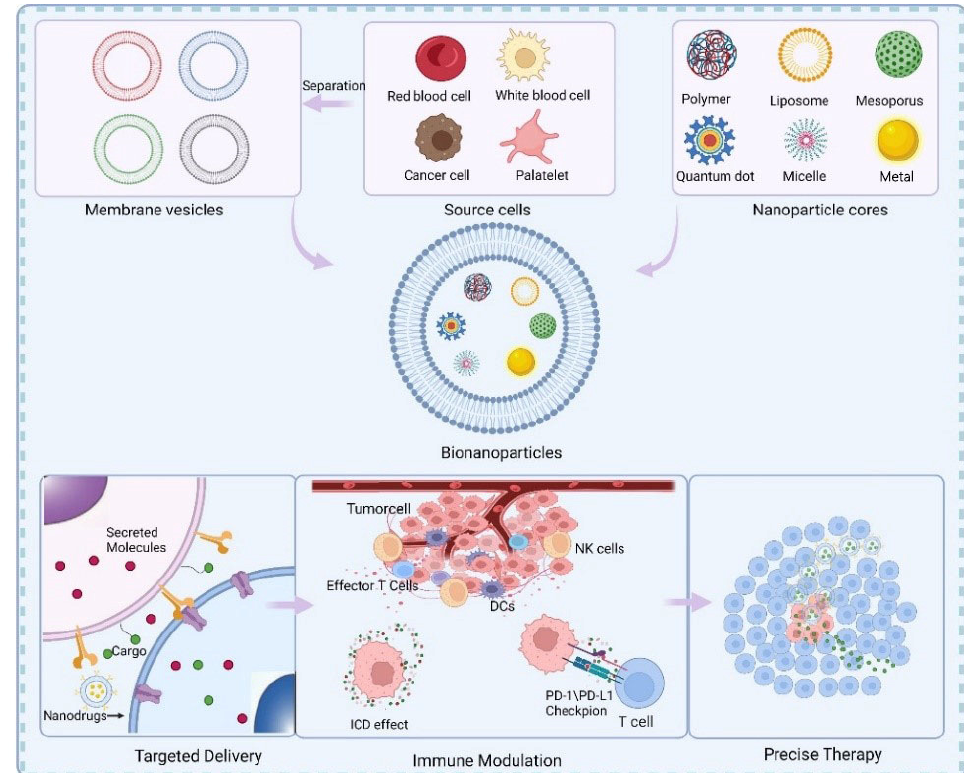
Figure 1. A schematic diagram of the preparation of membrane-coated biomimetic nanoparticles and their functions. The biocompatibility and functionality of nanoparticles could be improved by means of membrane coating. A wide range of cell sources can be used for membrane sources including blood red blood cells, white blood cells, tumor cells, platelets, etc. The membrane-coated biomimetic nanoparticles could effectively regulate the immune microenvironment through various effects such as immunogenic cell death (ICD) induction, ultimately achieving the precise treatment of tumors.